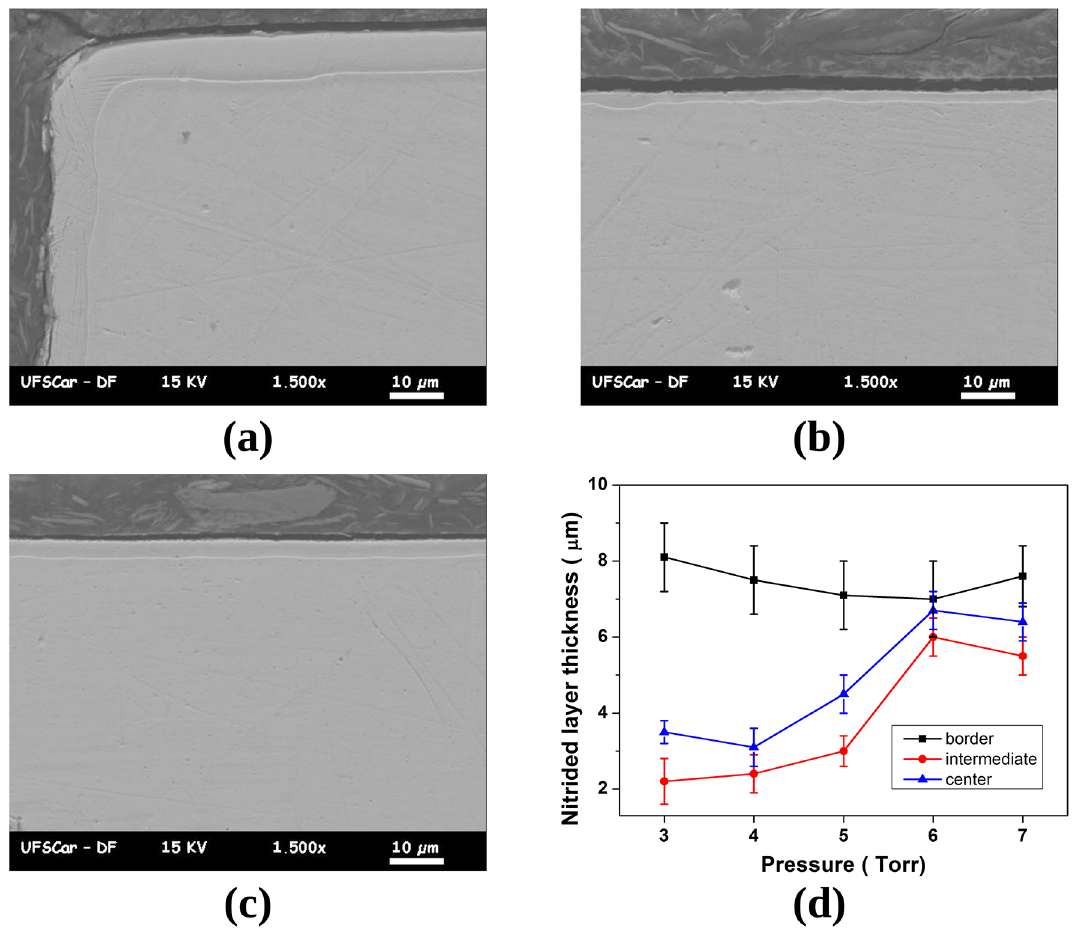
Figure 2. SEM micrographs of the P3 sample, nitrided at 3 Torr, for different regions: (a) border; (b) intermediate; (c) central; (d) thickness measurements for different regions as a function of the nitriding